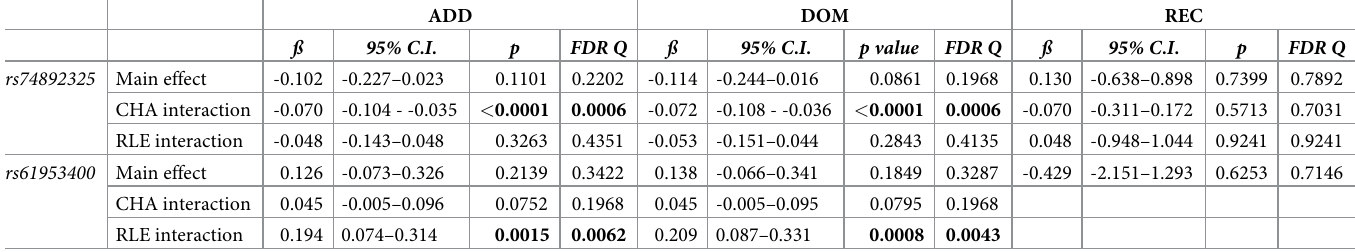
Table 3. Main effects and interactions with childhood adversities (CHA) and recent life events (RLE) of P2RX7 tops SNPs rs74892325 and rs61953400 on current depression symptom severity. ADD DOM